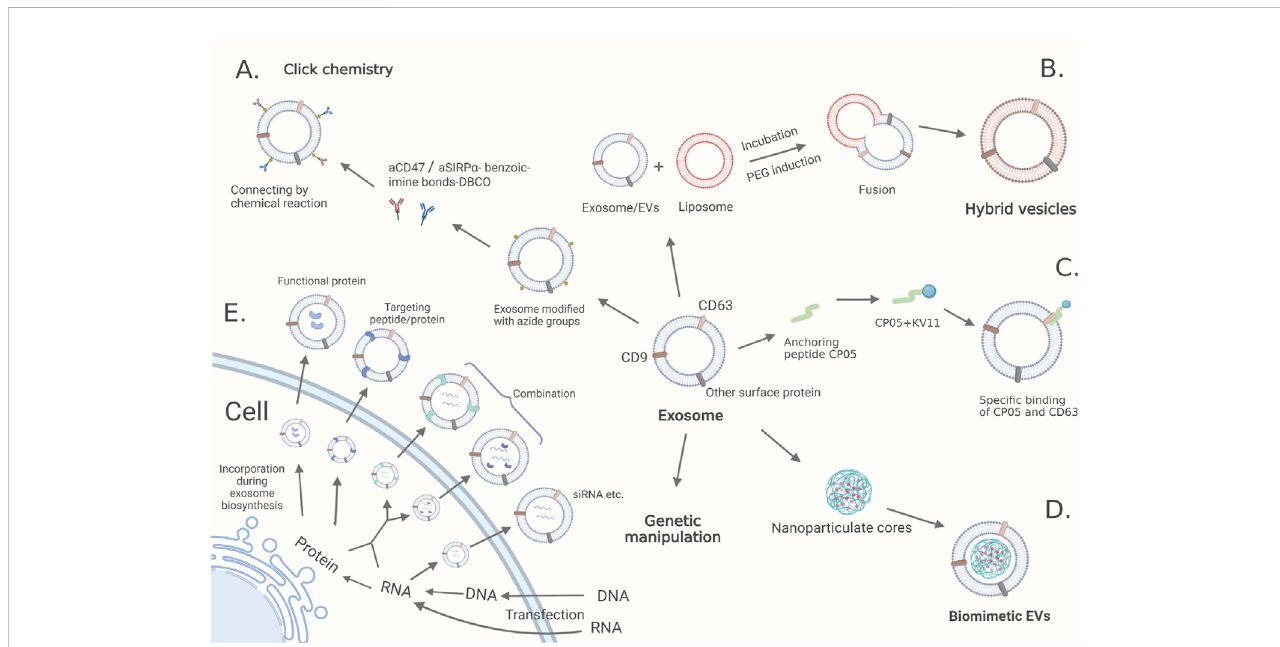
FIGURE 1 Themodi fi cationmethodsofengineeredexosomes: (A) Clickchemistry.Exosomesaremodi fi edwithazidegroupsthroughtheintrinsicbiosynthesisand metabolic incorporation of phospholipids. Then azide-modi fi ed exosomes are conjugated with the dibenzocyclooctynes (DBCO)-modi fi ed anti-CD47 antibody (aCD47) and anti-signal regulatory protein alpha (SIRP α ) antibody (aSIRP α ) linked with pH-sensitive benzoic-imine bonds. (B) Hybrid vesicles. Polyethylene glycol (PEG) and incubation induce ef fi cient fusion between exosomes/EVs and liposomes. (C) Anchoring peptides. Anchoring peptide CP05linkedwithKV11(ananti-angiogenicpeptide)boundsspeci fi callytoCD63. (D) BiomimeticEVs.Nanoparticulatecoresareembeddedintotheexosomes by electroporation. (E) Genetic manipulation. Transfected nucleic acids or their protein producs are loaded through the intrinsic biosynthesis of